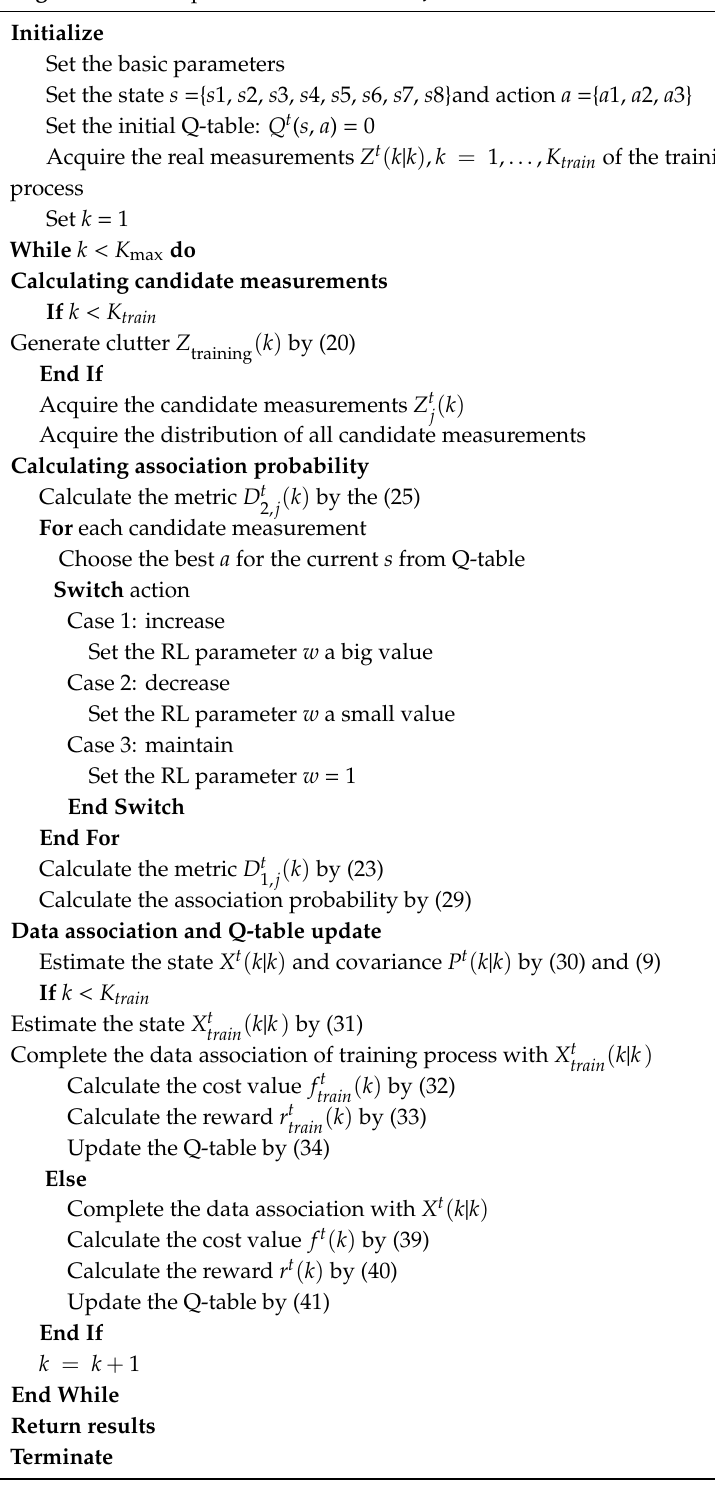
Algorithm 2. The pseudocode for the RL-JPDA